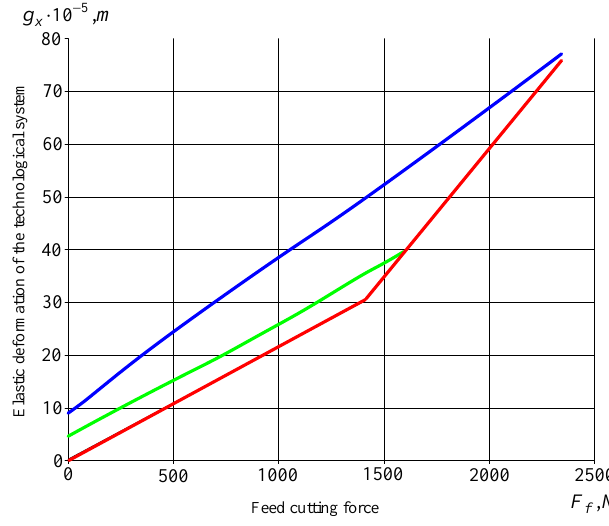
Figure 6. X Static characteristics for the X coordinate.